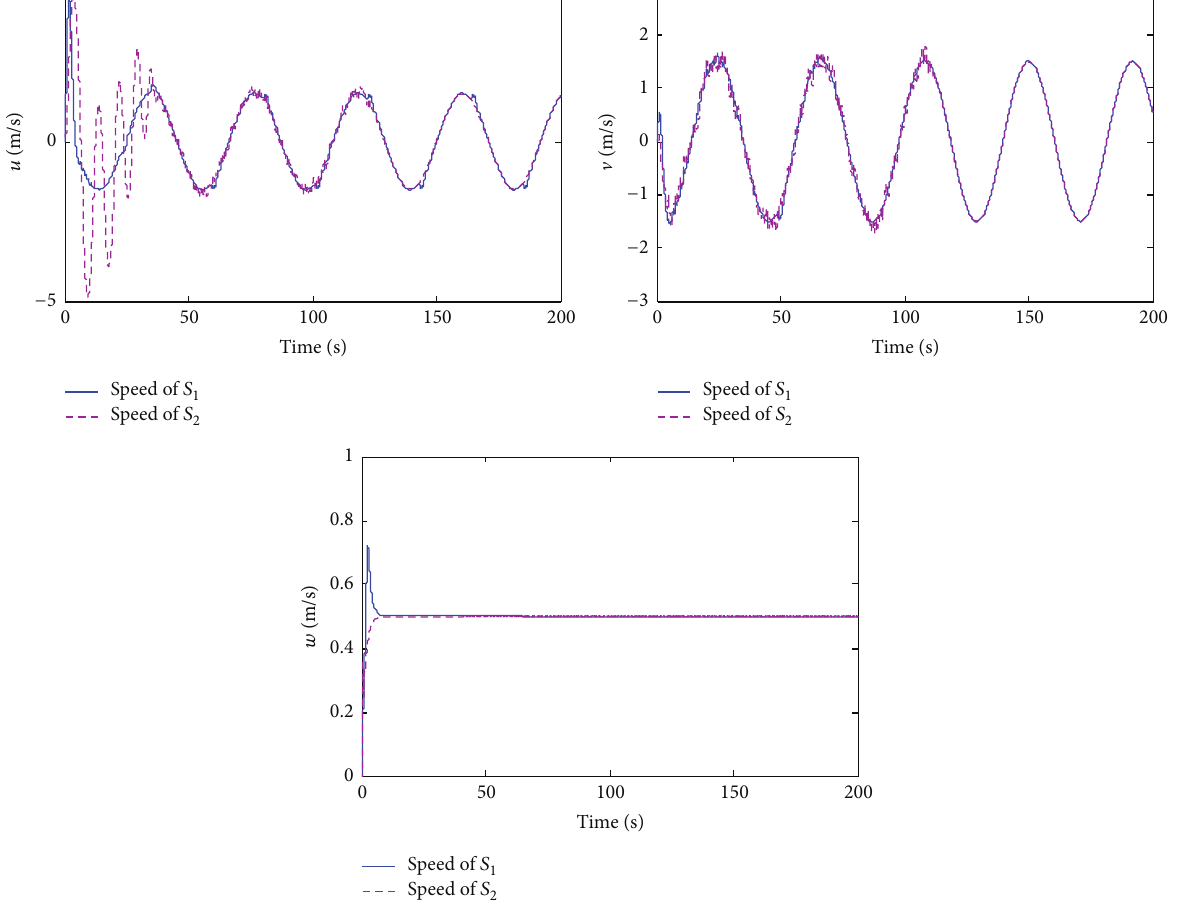
Figure 5: UAV flight path tracking results of the speeds (𝑢, V , 𝑤)